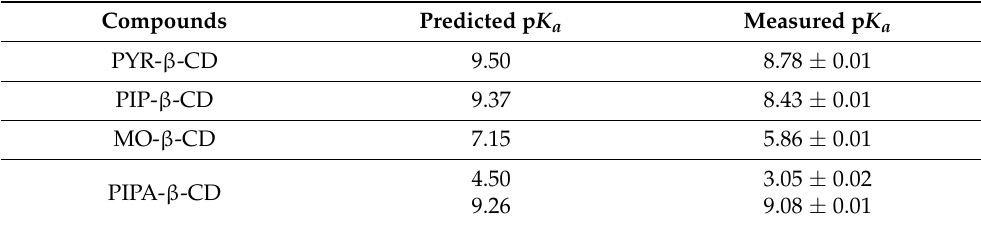
Table 1. Predicted and Measured p K a Values of the pH-Adjustable CD